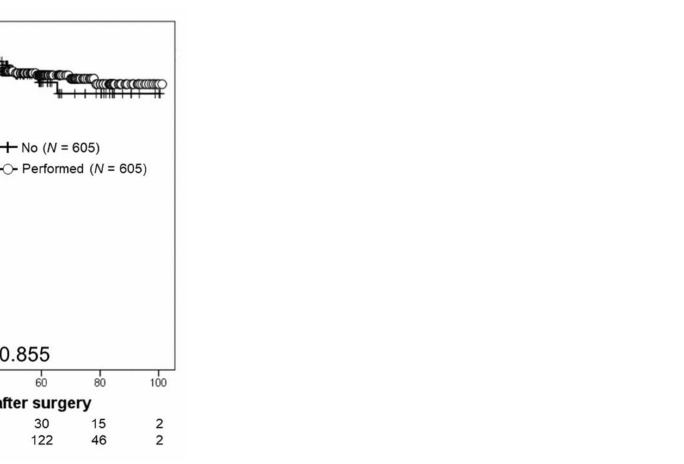
Figure 2. Kaplan–Meier estimates of biochemical recurrence-free survival according to the presence or absence of pelvic lymph node dissection (PLND). The 2-year BRFS rate was 95.8% in the non-PLND group and 94.3% in the PLND group.